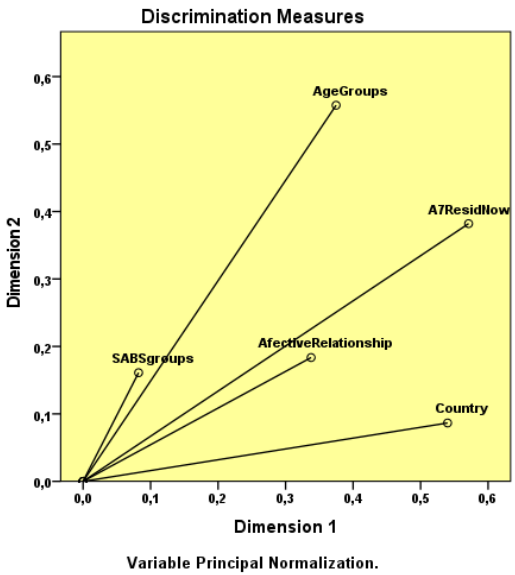
Figure 4. Discriminant measures.